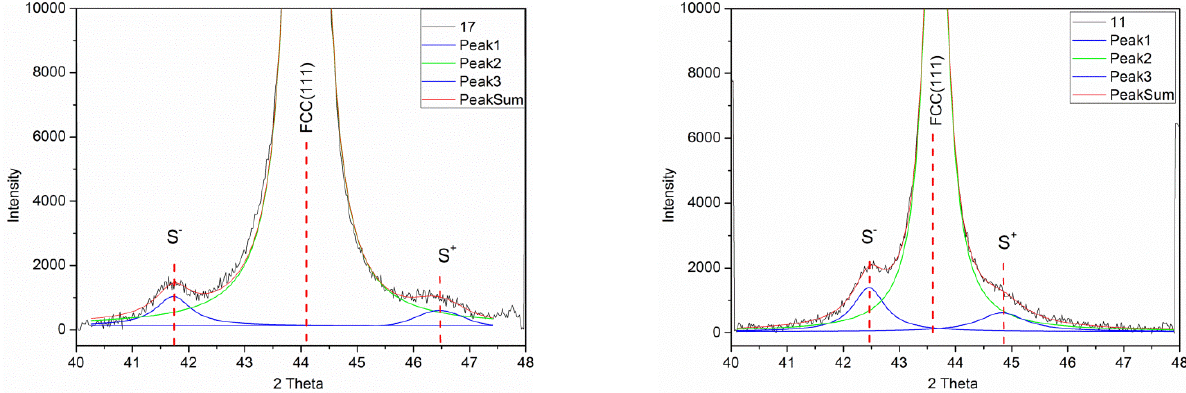
Figure 1. XRD pattern (black line) around the main fcc(111) reflection for the Ni-Co/Cu multilayers with t Cu = 1 nm (sample 17, left panel ) and t Cu = 5.0 nm (sample 11, right panel ) spacer layers. The green line represents the fit for the main reflection (peak 2), and the blue lines represent the fits for the lower-angle satellite peak S − (peak 1) and the higher-angle satellite peak S + (peak 2). The red line is the sum of the three fitted peaks. From the satellite peak positions the bilayer length was obtained as Λ XRD = 4.0 nm for sample 17 ( Λ nom = 3.0 nm) and Λ XRD = 8.0 nm for sample 11 ( Λ nom = 7.0 nm).